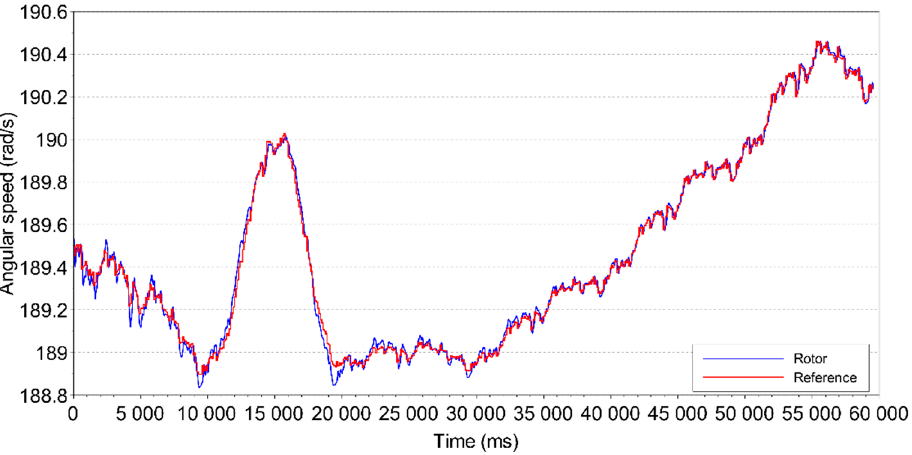
Figure 11. Angular speed of the rotor by wind speed variations.